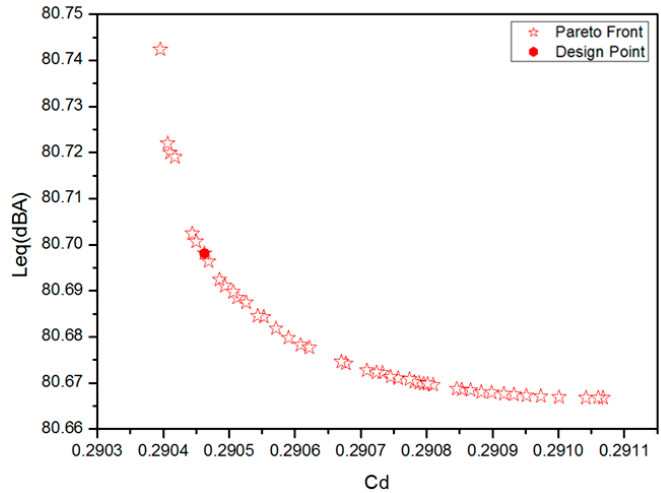
Figure 12. The Pareto front based on the drag of the whole train and the equivalent continuous SPL. The drag coefficient of the whole train and the equivalent continuous SPL for the prototype of EMU1 are 0.314 and 81.93 dBA, respectively, while the objectives in the Pareto set are all more optimal than those of the prototype.